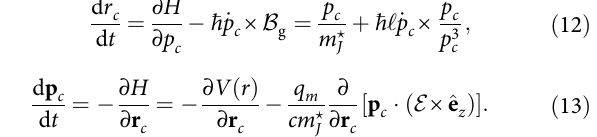
ffiffiffiffiffiffiffiffiffiffiffiffiffiffiffiffi p (cid:1) h = q jBj is a characteristic width that depends on m the amplitude of the applied electric fi eld, Ω the Larmor frequency ( σ = ±1 correspond to the clockwise or